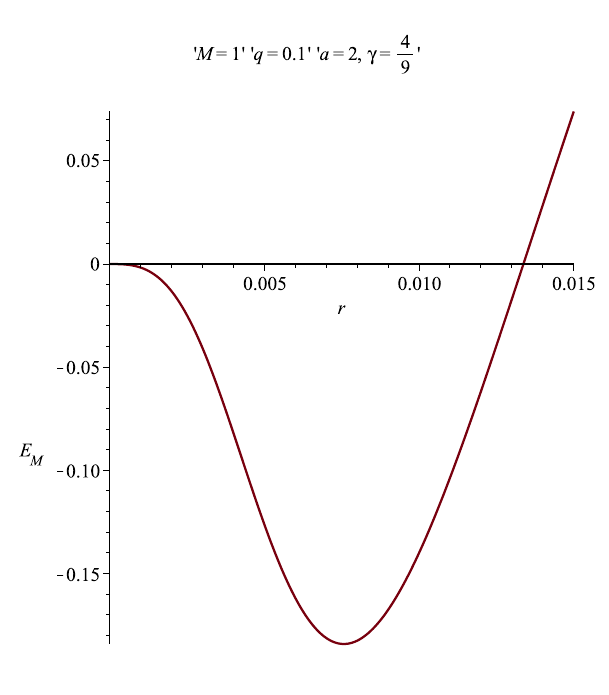
Figure 8. Møller energy versus the radial distance r near the origin.